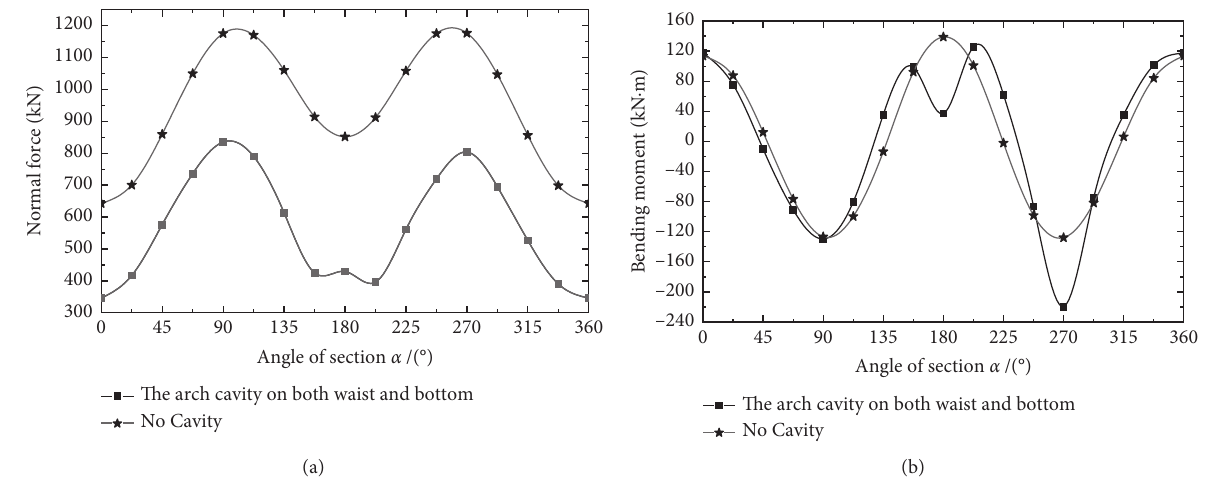
Figure 24: Internal force diagram of the cavity behind the arch waist and arch bottom. (a) Segment axial force. (b) Segment bending moment.